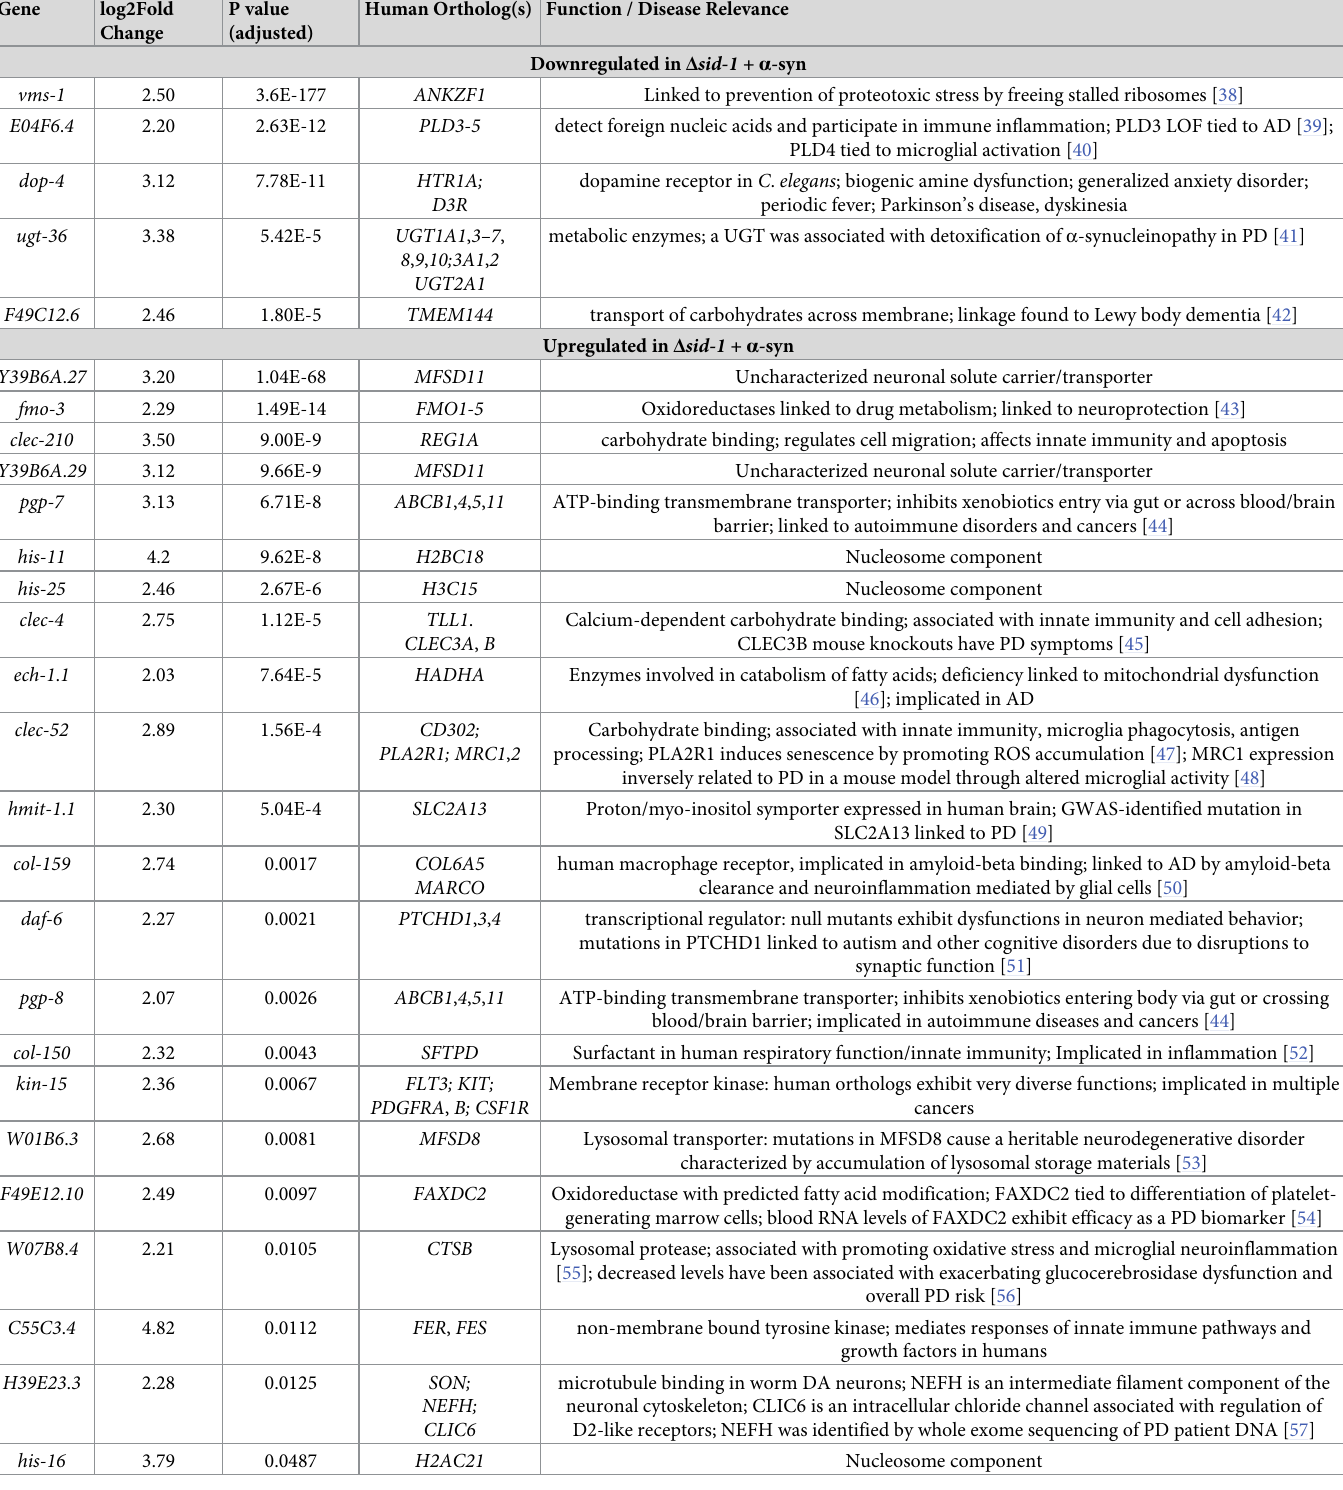
Table 1. Differentially Expressed Genes (DEGs): α -syn vs. α -syn + Δ sid-1 . Gene log2Fold